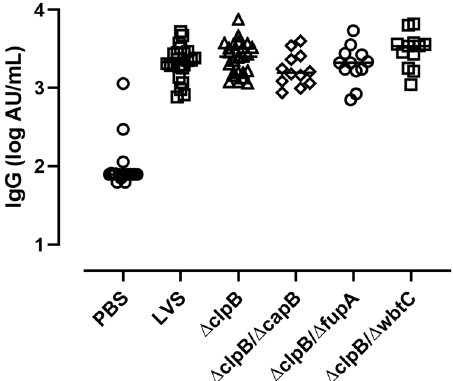
Fig. 5 Anti- Francisella antibody titers do not show obvious differences across vaccine groups. Fischer rats ( n = 12 – 24) were vaccinated as indicated. Thirty-nine days after vaccination, serum samples were collected and analyzed for IgG antibodies using plates coated with heat-killed SchuS4. The results from two independent studies are shown; values indicate the median titer for each sample analyzed from one to four times. All vaccines induced antibodies against SchuS4 ( P < 0001 vs. PBS), and pair-wise comparisons indicated the only signi fi cant difference is between Δ clpB- Δ capB and Δ clpB- Δ wbtC sera ( P = 0.03).